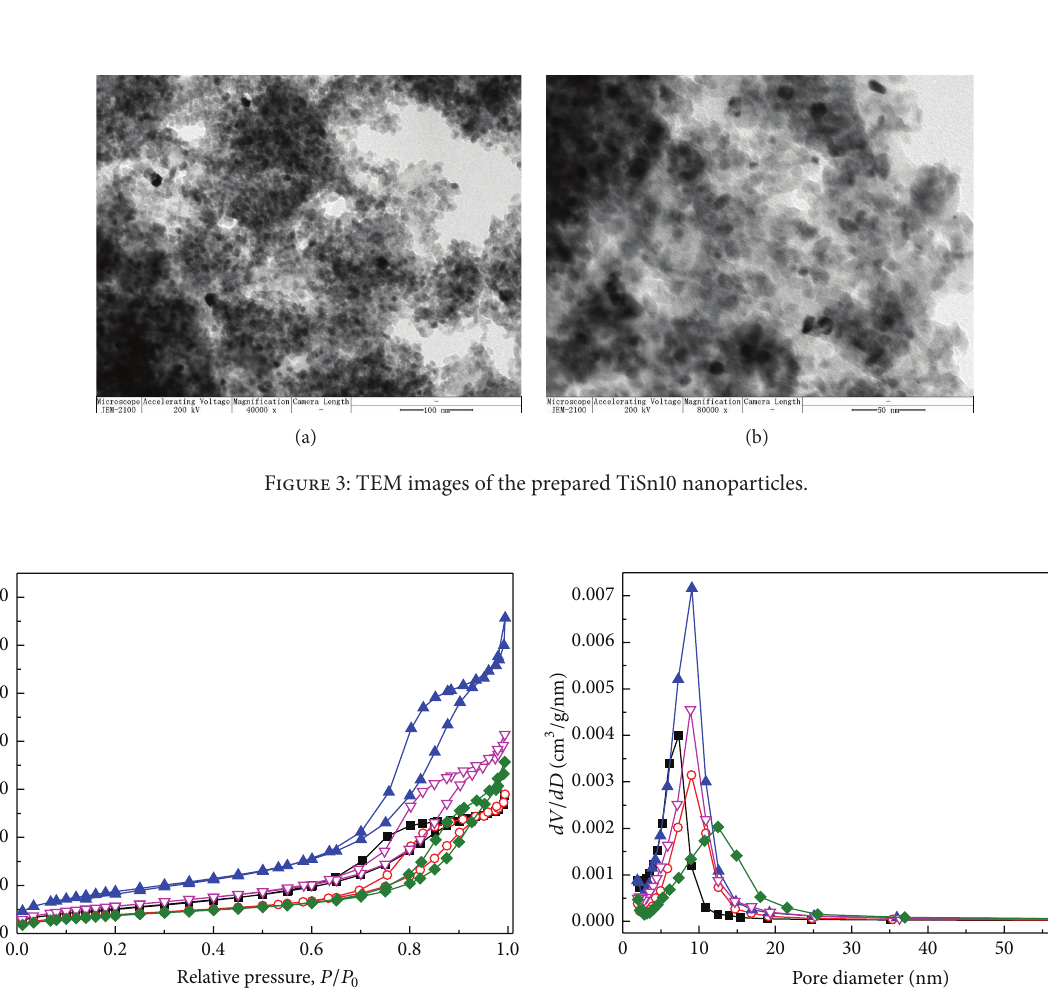
Figure 2: LRTEM (Low resolution TEM) images of the prepared TiSn10 nanoparticles.